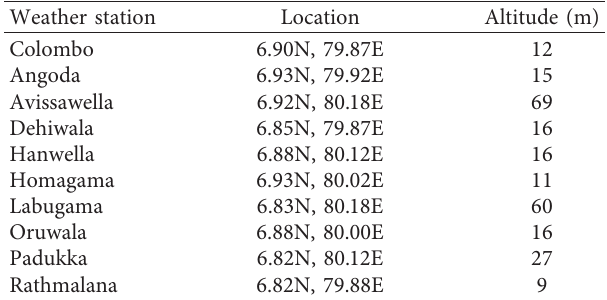
Table 1: Details of the selected weather stations of Colombo district.